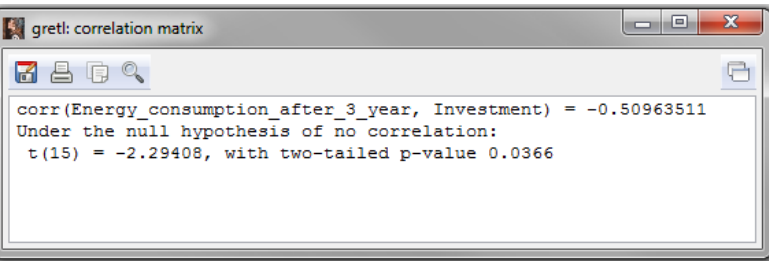
Figure 7. Correlation value for both tested variables and a 3-year energy consumption variable.